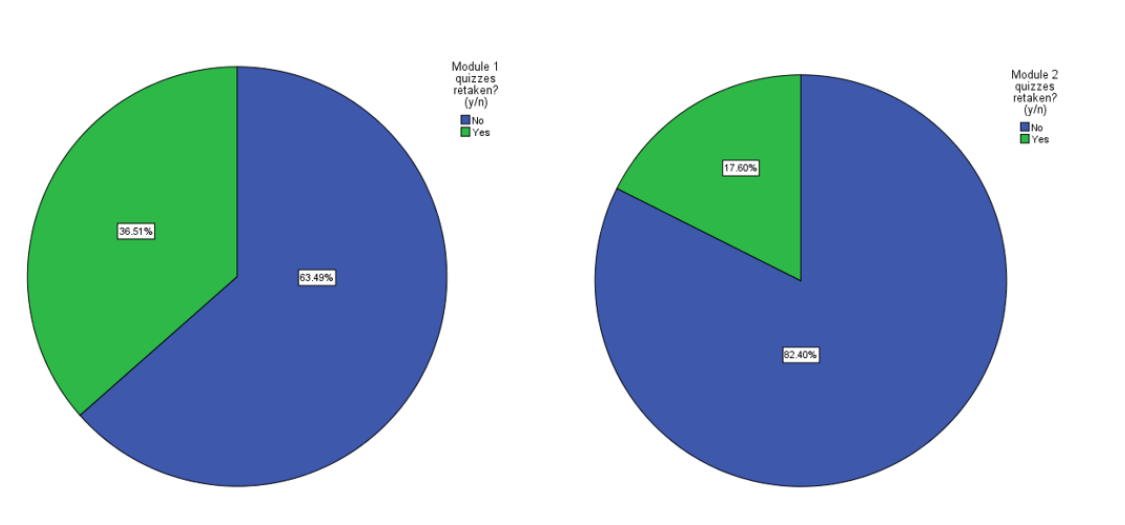
Figure 6: Percentages of cohort who retook quizzes in Modules 1 and